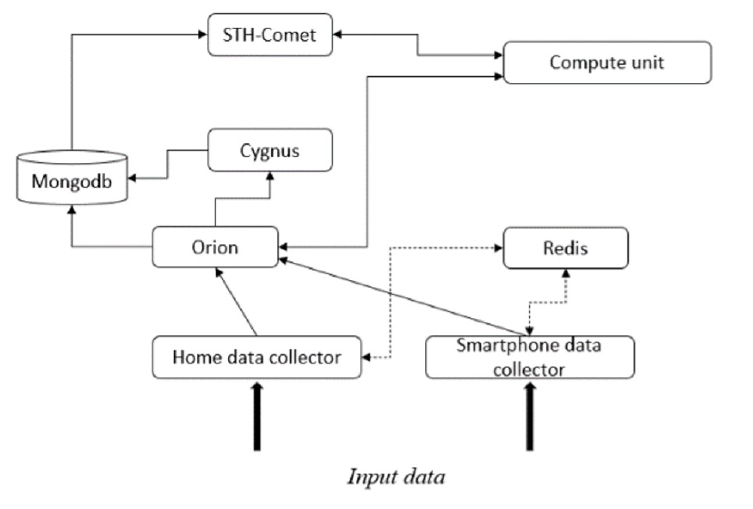
Figure 2. e-VITA data fusion platform